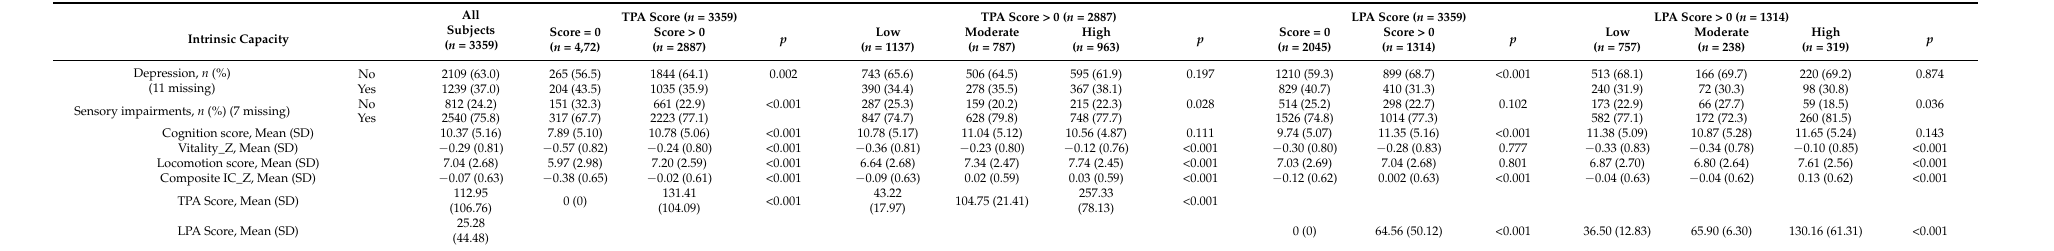
Table 2. Summary of IC and IC domains by different TPA/LPA